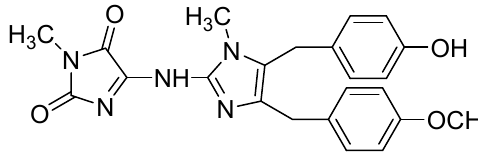
Figure 2. Structure of naamidine A.